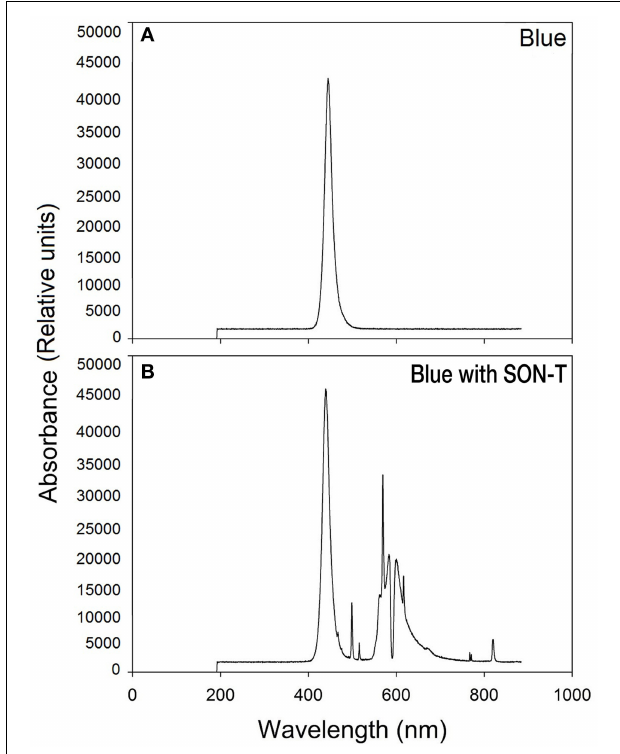
FIGURE 1 | Spectral distribution of blue (A) and blue with SON-T light